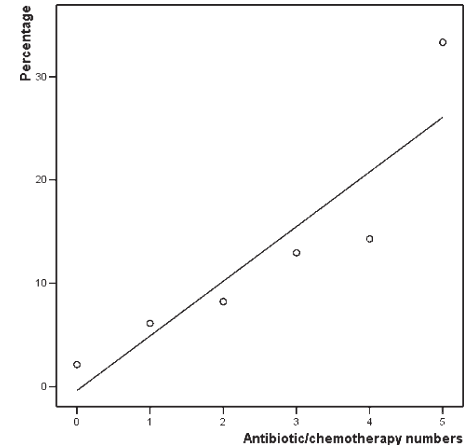
Figure 1 - Linear correlation line of number of anti-infective agents versus fatal outcome (all patients, n =